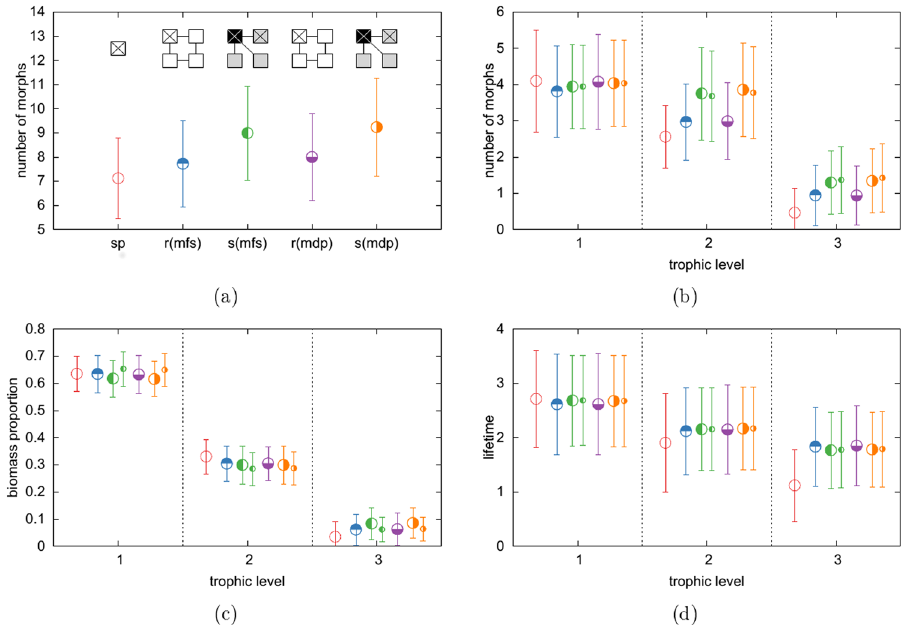
Figure 5. Properties of food webs of 5 different scenarios: single patch (sp), ring - migration from the start (mfs), star - migration from start (mfs), and migration after development (mdp) for the previous two scenarios. (a) Global diversity (b) Number of morphs per trophic level (c) Distribution of biomass over trophic levels (d) Average lifetime, measured as decimal logarithm of the mutation events survived. Data shown for the marked habitats, smaller symbols indicate the properties on the satelite patch. Error bars correspond to standard